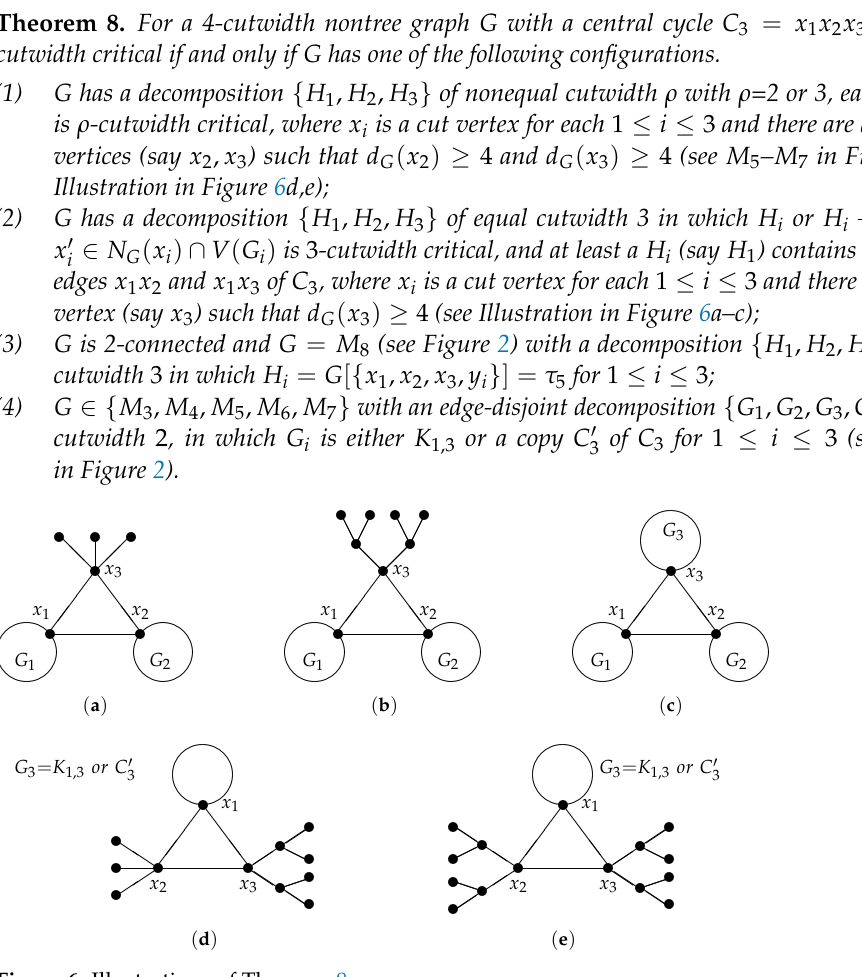
Figure 6. Illustrations of Theorem